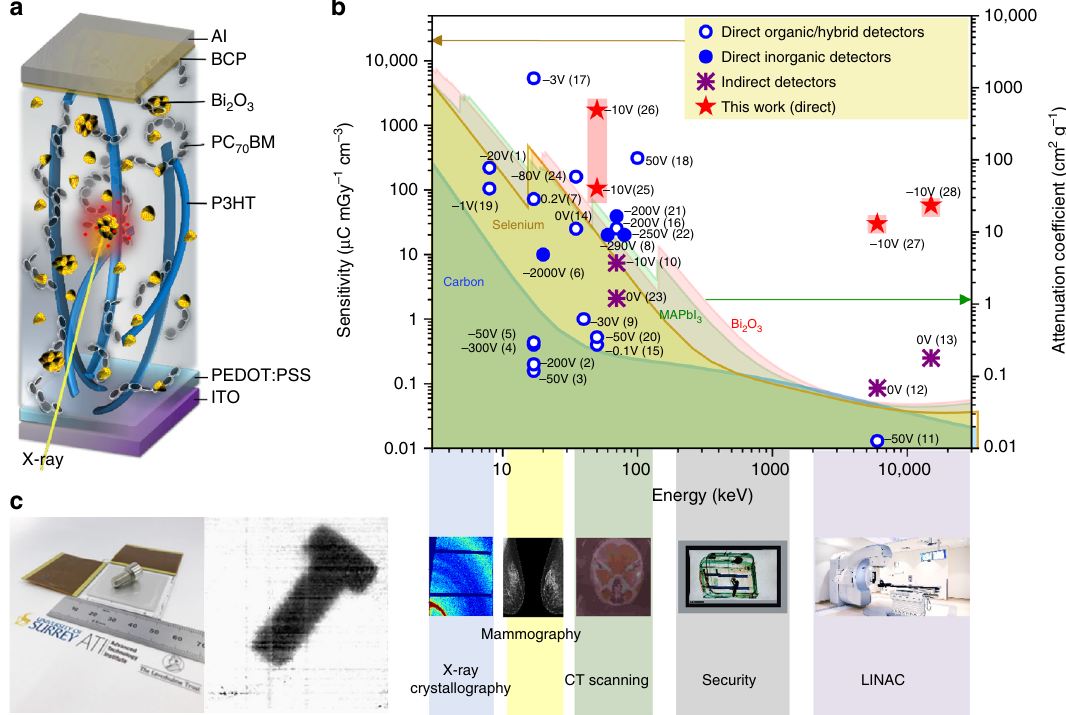
Fig. 1 X-ray detector overview. a Device schematic structure. b Performance comparison of current solid state X-ray detectors — (1) 13 , (2) 10 , (3) 36 , (4) 37 , (5) 38 , (7) 8 , (9) 11 , (11) 3 , (14) 39 , (15) 40 , (16) 7 , (17) 41 , (18) 42 , (19) 43 , (20) 44 , and (24) 20 are direct detectors, (6) 45 , (8) 46 , (21) 7,47 and (22) 48 are inorganic detectors, and (10) 12 , (12) 9 , (13) 25 and (23) 49 are indirect detectors — with the technology developed in this work — (25) Bi 2 O 3 -40, (26) Bi 2 O 3 -80, (27) Bi 2 O 3 -40 and (28) Bi 2 O 3 -40. The operating voltage is given adjacent to each data point. The total attenuation coef fi cient values of carbon, selenium, methylammonium lead iodide (MAPbI 3 ) and Bi 2 O 3 are given as shaded areas showing the previous limits to detector technology based only on bulk attenuation processes. c An X-ray imager based on the hybrid X-ray detector and 70 kV X-ray image of a bolt taken using the X-ray